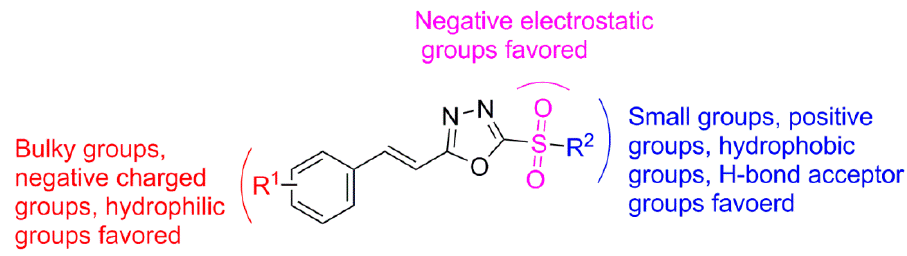
Figure 9. The structure – activity relationship (SAR) summarized based on our work.